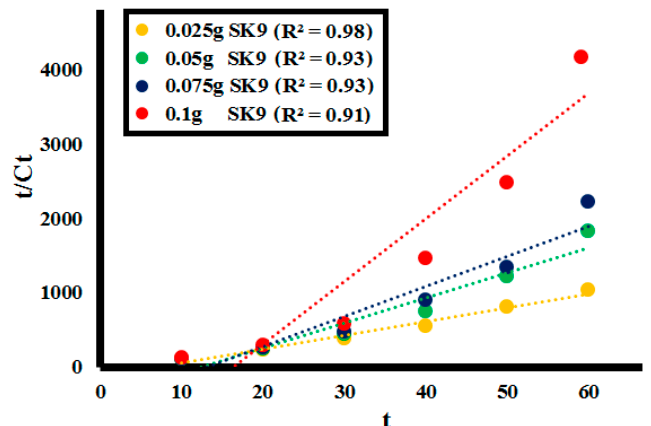
Figure 15. Pseudo-second order kinetics of the lignin ( L1 100ppm ) depolymerization by different catalytic doses (0.025–0.1 g) of SK9 .